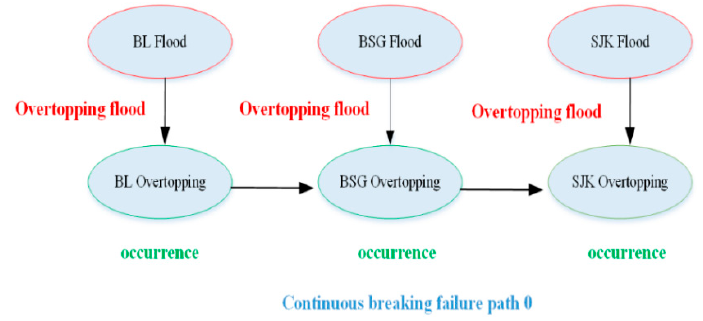
Figure 6. The continuous breaking failure path 0.